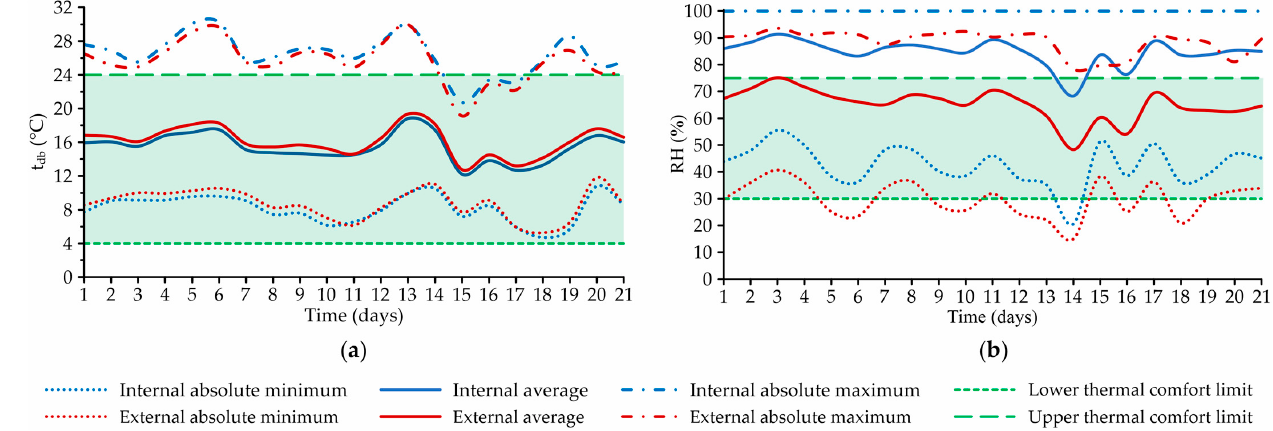
Figure 2. Daily curves of the mean, absolute minimum, and absolute maximum values of ( a ) dry-bulb air temperature (t db , in °C) and ( b ) relative air humidity (RH, in %) in the internal and external environments of the open compost-bedded pack barn system throughout the experimental period.